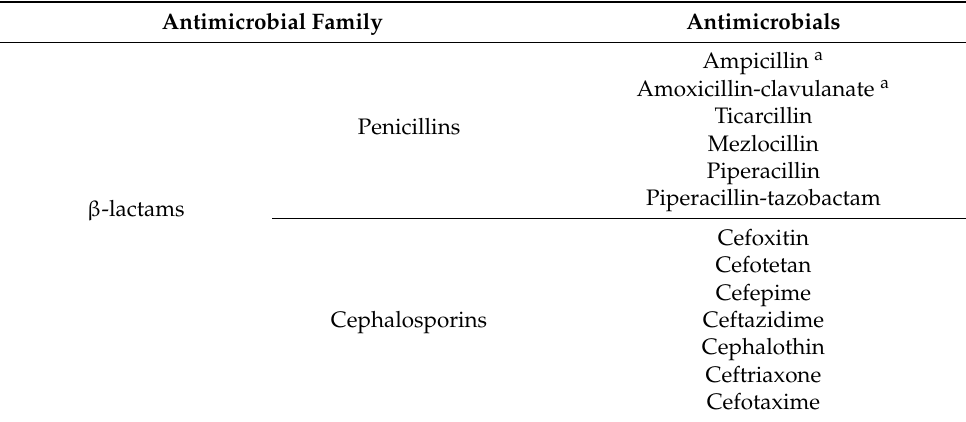
Table 1. Antimicrobial resistance described in A. baumannii